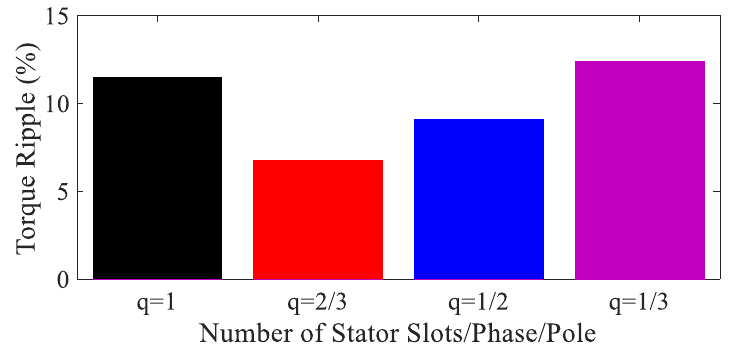
Figure 10. Cogging torque of the initial models.